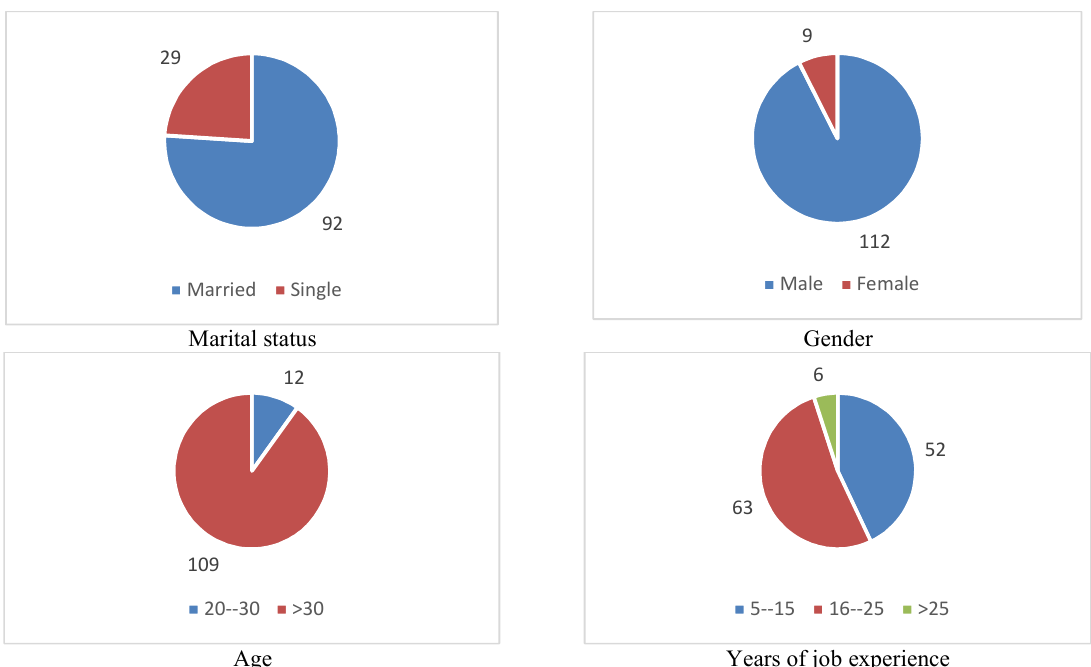
Fig. 2. Personal characteristics of the participants